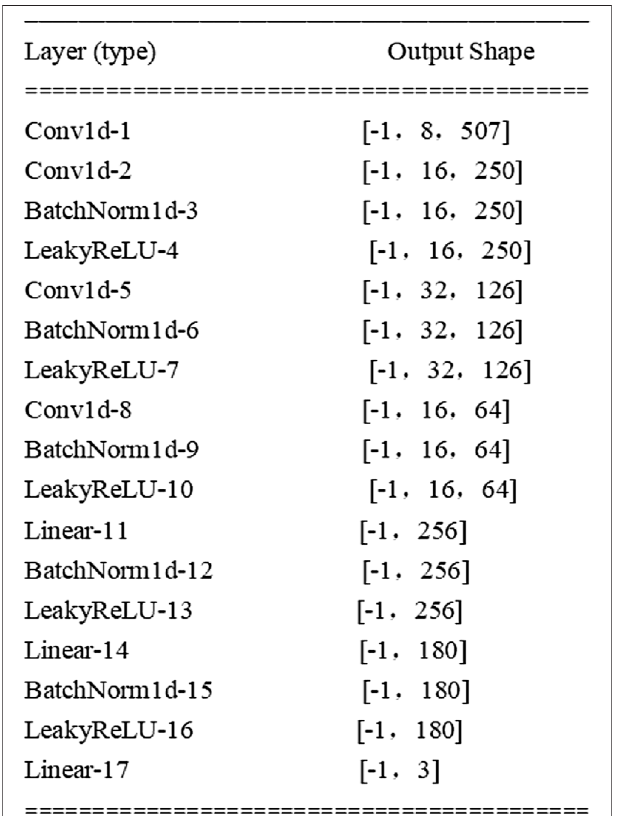
FIGURE 2 | 1D-CNN output size of each network